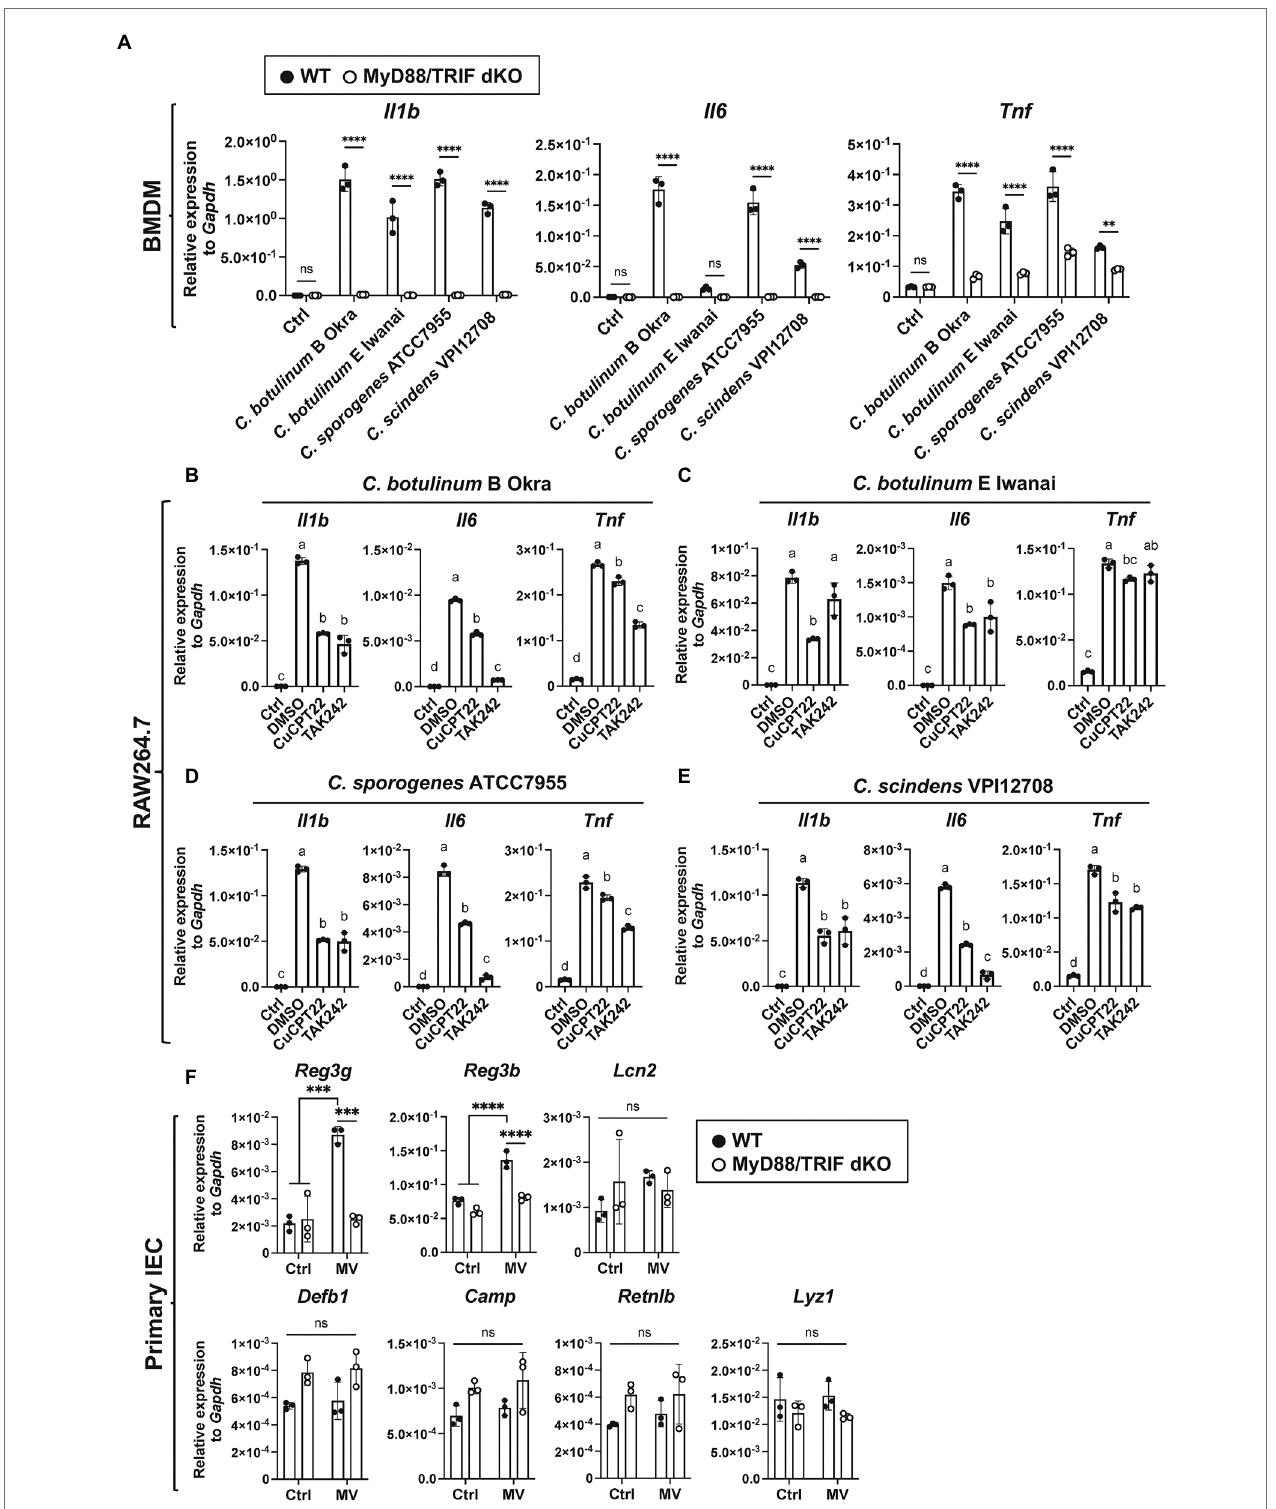
FIGURE 4 | MyD88/TRIF-dependent innate immune responses against clostridial MVs. (A) WT or MyD88/TRIF dKO BMDMs were treated with 10 μ g/ml MVs derived from C. botulinum type E Iwanai, C. sporogenes ATCC7955, or C. scindens VPI12708 for 6 h. Gene expression levels were measured using a RT-qPCR analysis. Ctrl, control; ** , p < 0.01; **** , p < 0.0001; ns, not significant. Error bars indicate SD. n = 3, a two-way ANOVA with Šídák’s multiple comparisons post hoc